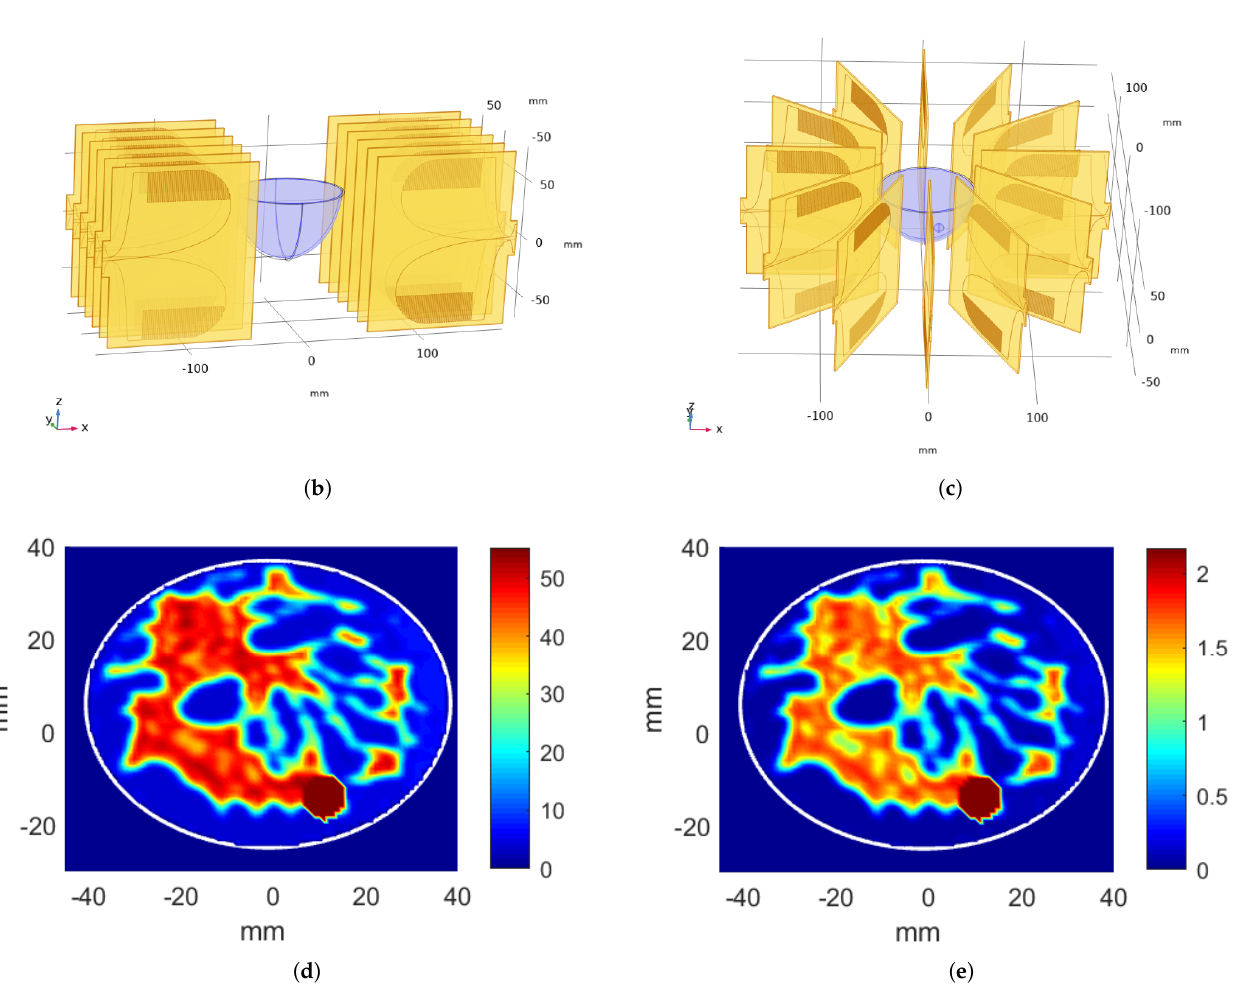
Figure 1. Microwave hyperthermia (MH) applicator configurations: ( a ) S11 parameter vs. frequency graph of a single Vivaldi antenna. ( b ) Linear antenna system, ( b ) circular antenna system with a tumor. Dielectric properties of the central slice of the breast with tumor: ( d ) relative permittivity, ( e ) electrical conductivity